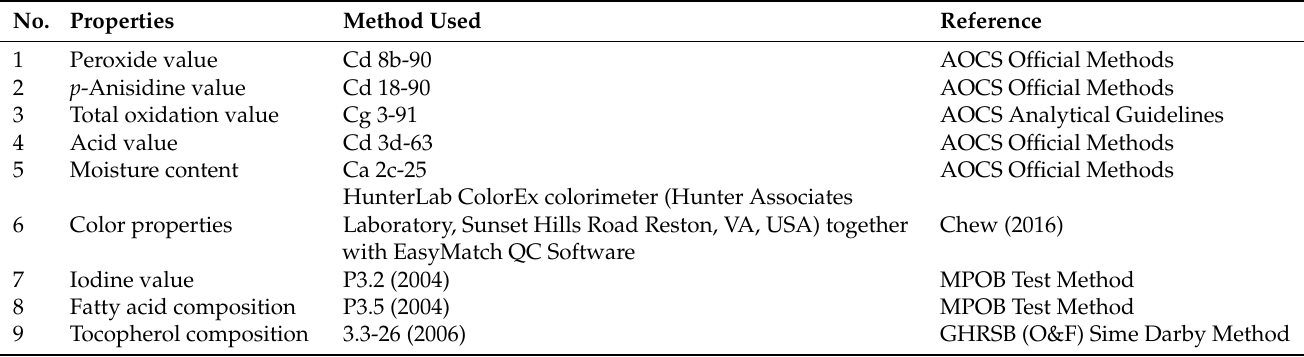
Table 1. Analytical methods used to determine the physicochemical and oxidative properties of Moringa oleifera kernel oil. No.